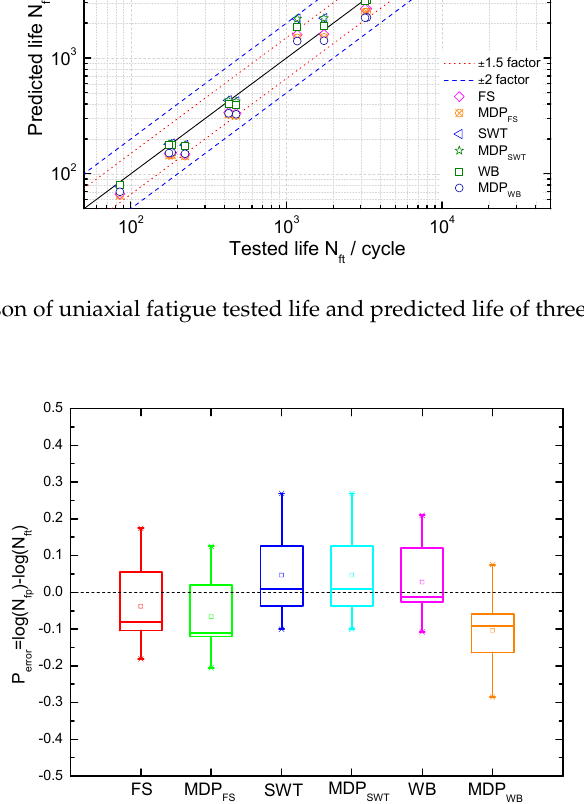
Figure 7. Box plot of model prediction errors for GH4169 under uniaxial loading at 650 °C.